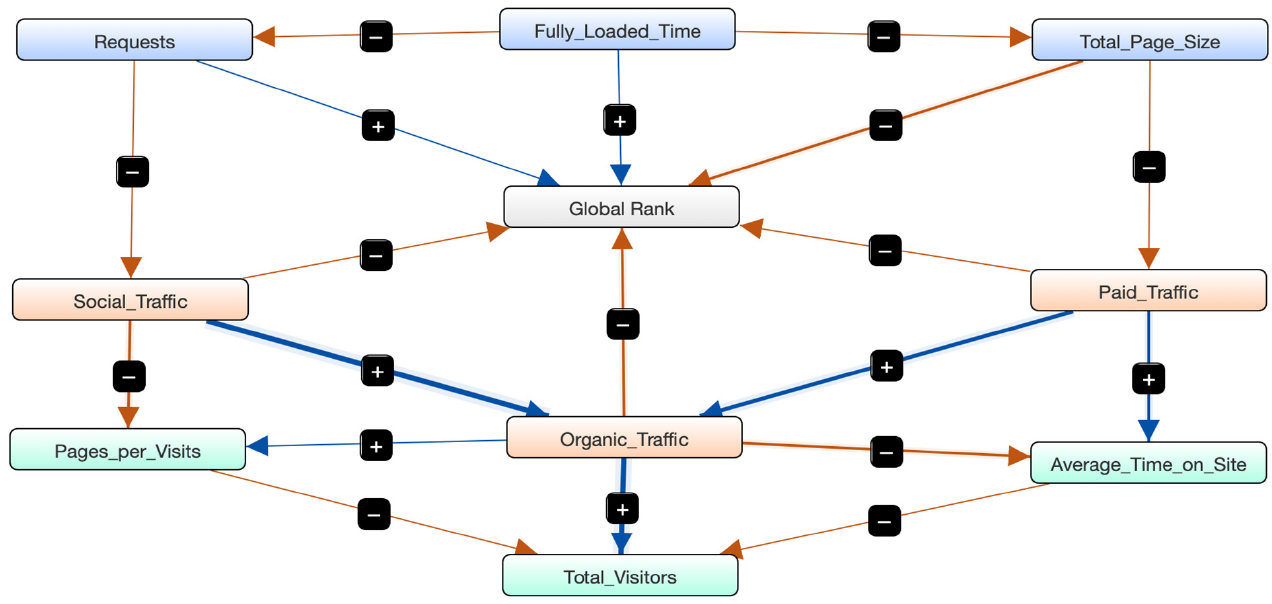
Figure 1. Fuzzy Cognitive Map illustration of the examined parameters.